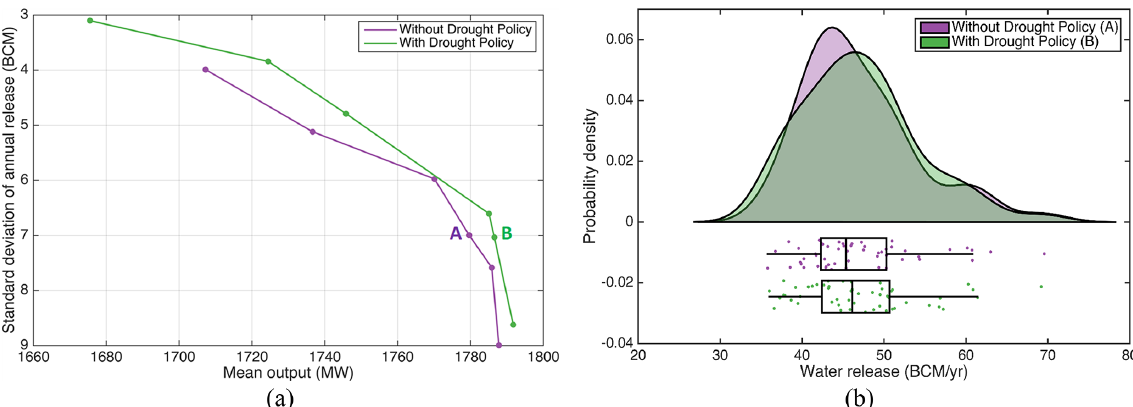
Figure 12. (a) Pareto fronts of reservoir operation with and without drought policy. (b) Box plot of reservoir storage for solutions A and B in the Pareto fronts, and kernel distribution of annual reservoir water releases with and without the drought